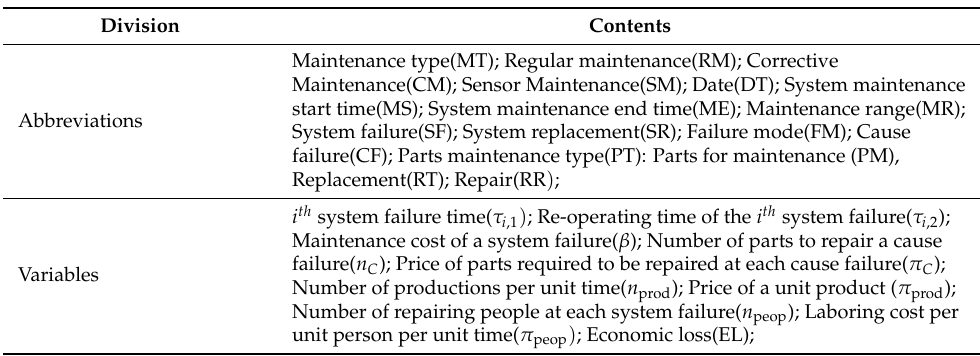
Table A1. Abbreviations and